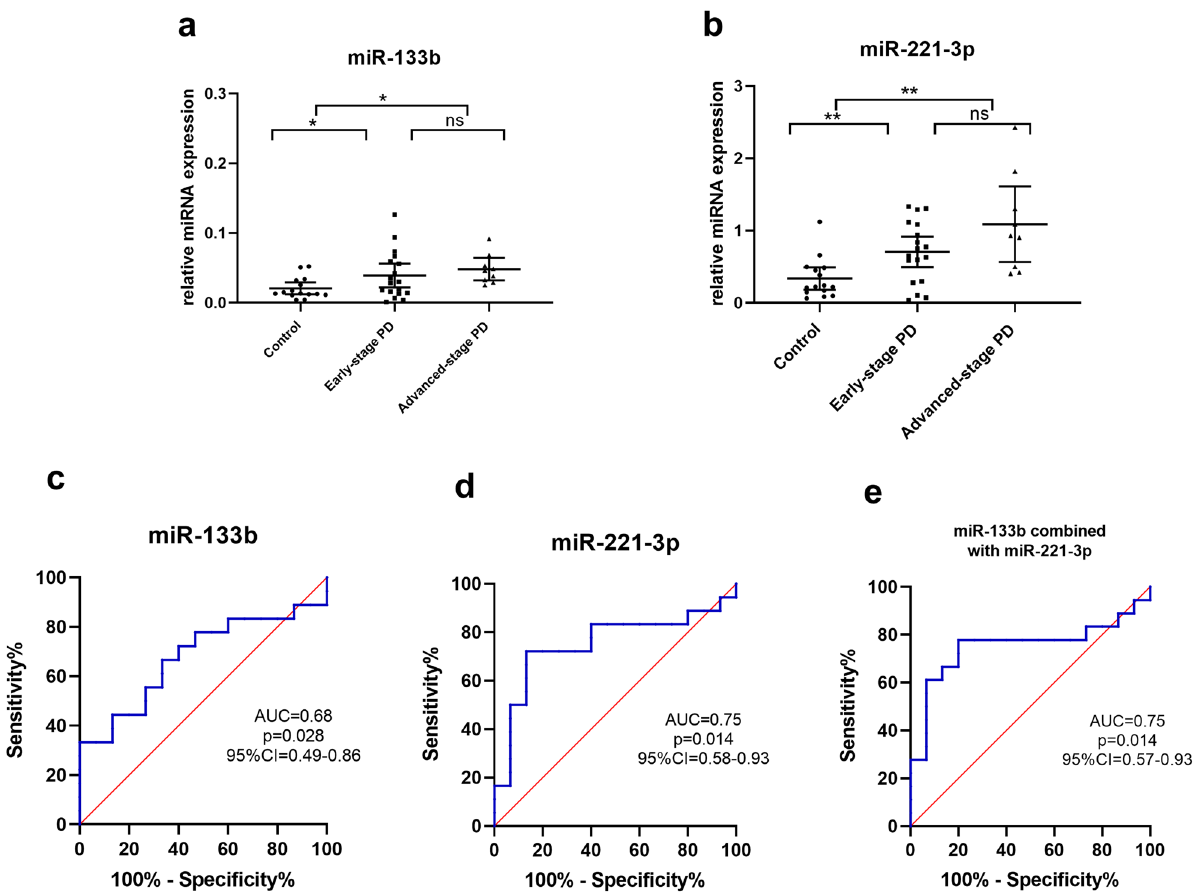
Figure 4. Plasma miR-133b ( a ) and miR-221-3p ( b ) expression in early-stage PD (modified H-Y stage 1–2.5, n = 18), advanced-stage PD (modified H-Y stage 3–5, n = 9) and healthy controls (n = 15) from cohort 2. ROC analysis of plasma miR-133b ( c ), miR-221-3p ( d ) and their combination ( e ) for discriminating patients with early-stage PD from healthy controls in cohort 2. The ANOVA with post-hoc was used to evaluate differences between groups. Data are presented as the means ± SEMs. The results are indicated as **adjust p value < 0.01 and *adjust p value < 0.05. PD, Parkinson’s disease.